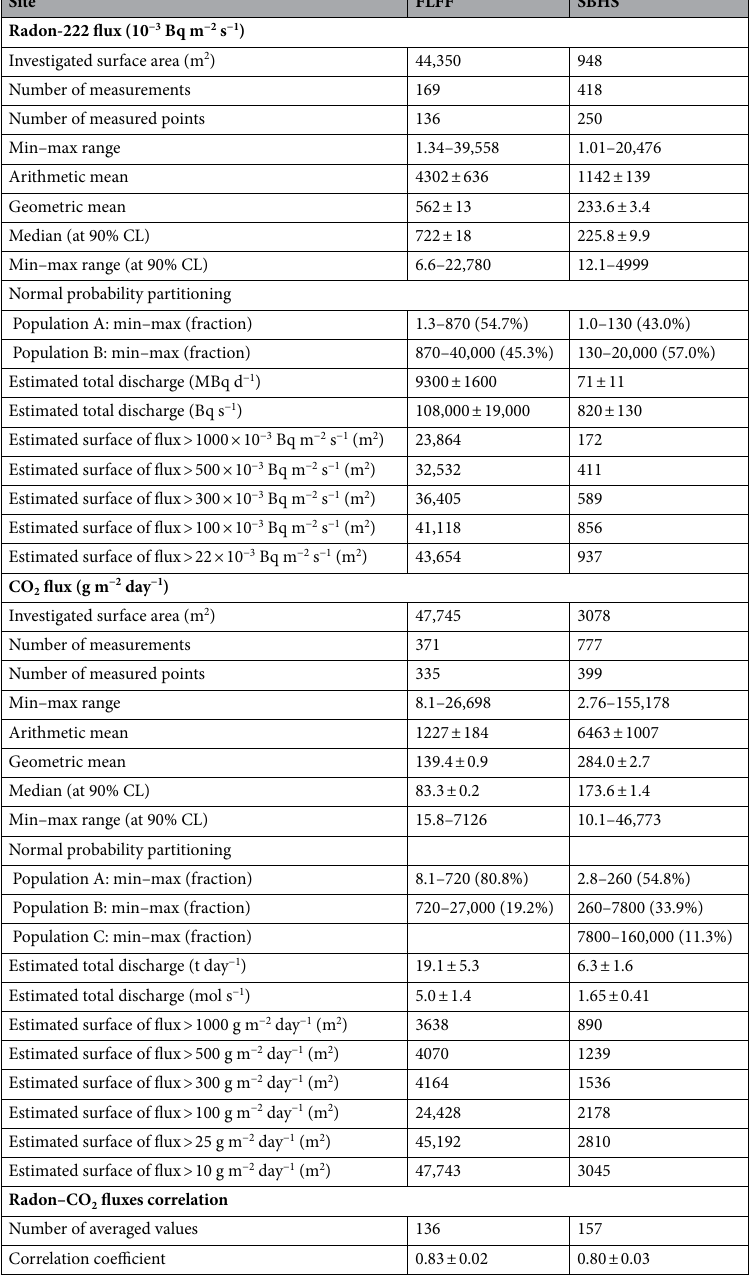
Table 1. Overview of radon and CO 2 flux data-set separately at Furnas Lake Fumarolic Field (FLFF) and Syabru-Bensi Hydrothermal System (SBHS). Estimated surface discharge of radon and CO 2 are also given for both sites. All experimental uncertainties are given at one standard deviation (1-σ, 68% confidence